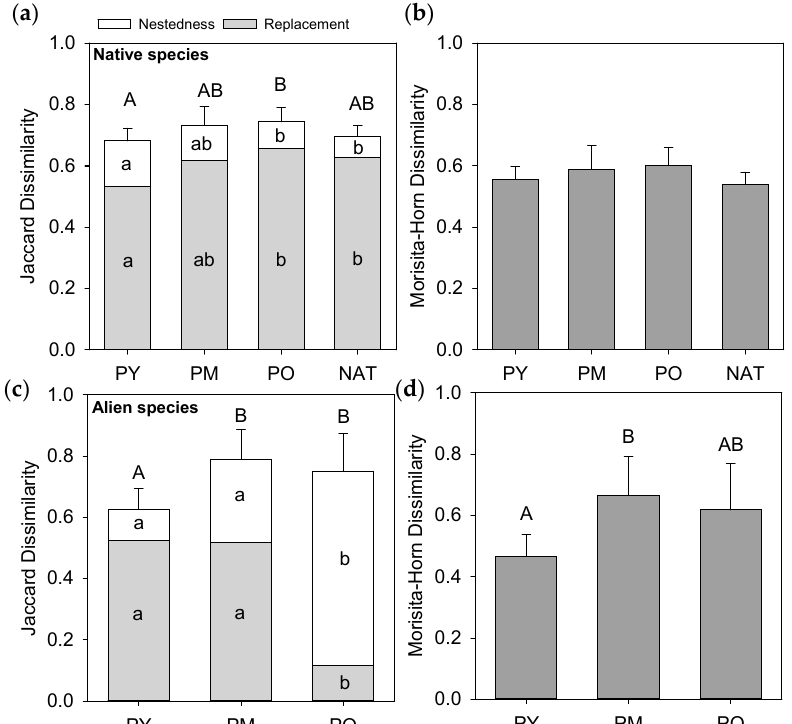
Figure 7. Mean pair-wise dissimilarity for native and alien species between roadside and interior transects within plantation age classes (PY = Young plantation, PM = medium-aged plantations, PO = old to mature plantations) and the natural forest (native species only). ( a , c ): Presence/absence-based Jaccard dissimilarity partitioned into the replacement and nestedness component according to Baselga [50] for native ( a ) and alien ( c ) species; ( b , d ): The abundance-based Morisita–Horn Index for native ( b ) and alien ( d ) species. Different lowercase letters indicate significant differences in replacement and nestedness component among forest types. Different uppercase letters indicate significant differences for the overall dissimilarity indices between forest types. As Pinus radiata was the only alien species in natural forest transects, alien species dissimilarity between forest and road transects was not considered for the natural forest.